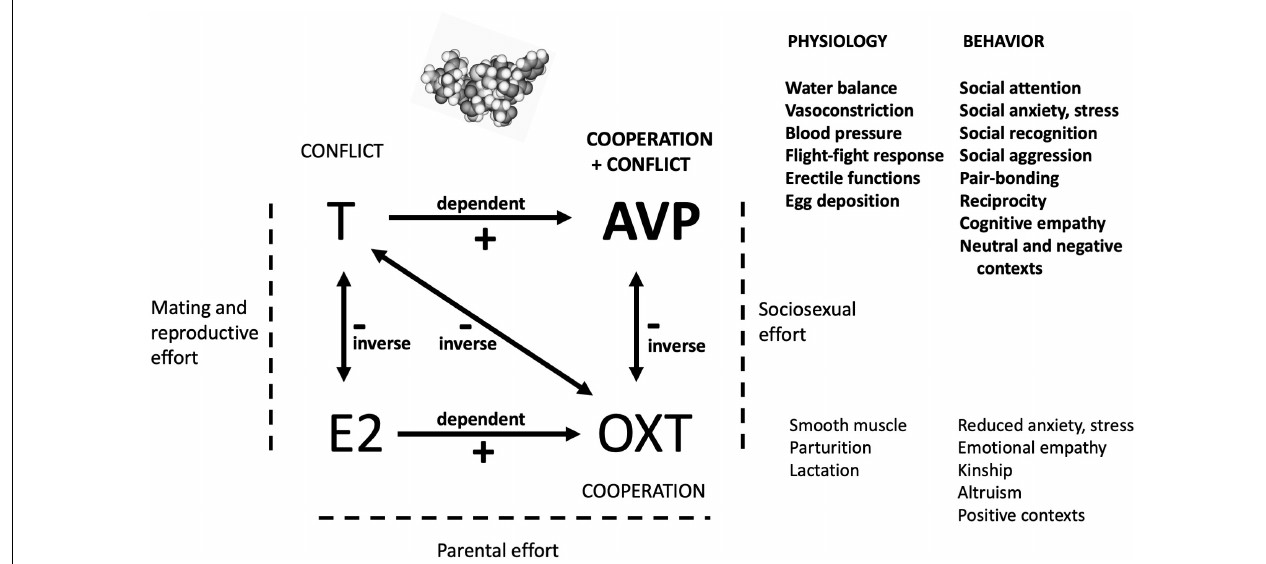
FIGURE 1 | A highly simplified diagram of the postulated primary effects of the four hormones analyzed here. By the hypothesis presented and evaluated in this study, AVP has evolved, from its simple ancestral physiological and behavioral functions, to orchestrate complex social cognition and behavior that involves mixtures of cooperation with conflict. The mediation of social and sociosexual situations by AVP depends upon levels of other hormones, as shown here. AVP is ideally placed in this broader context, given its dependence on T, its inverse relationship with OXT, and its effects as a neurotransmitter as well as a hormone. The roles of E2 in social-behavioral neuroendocrinology are insufficiently characterized for robust inferences regarding its specific functions in this domain to be